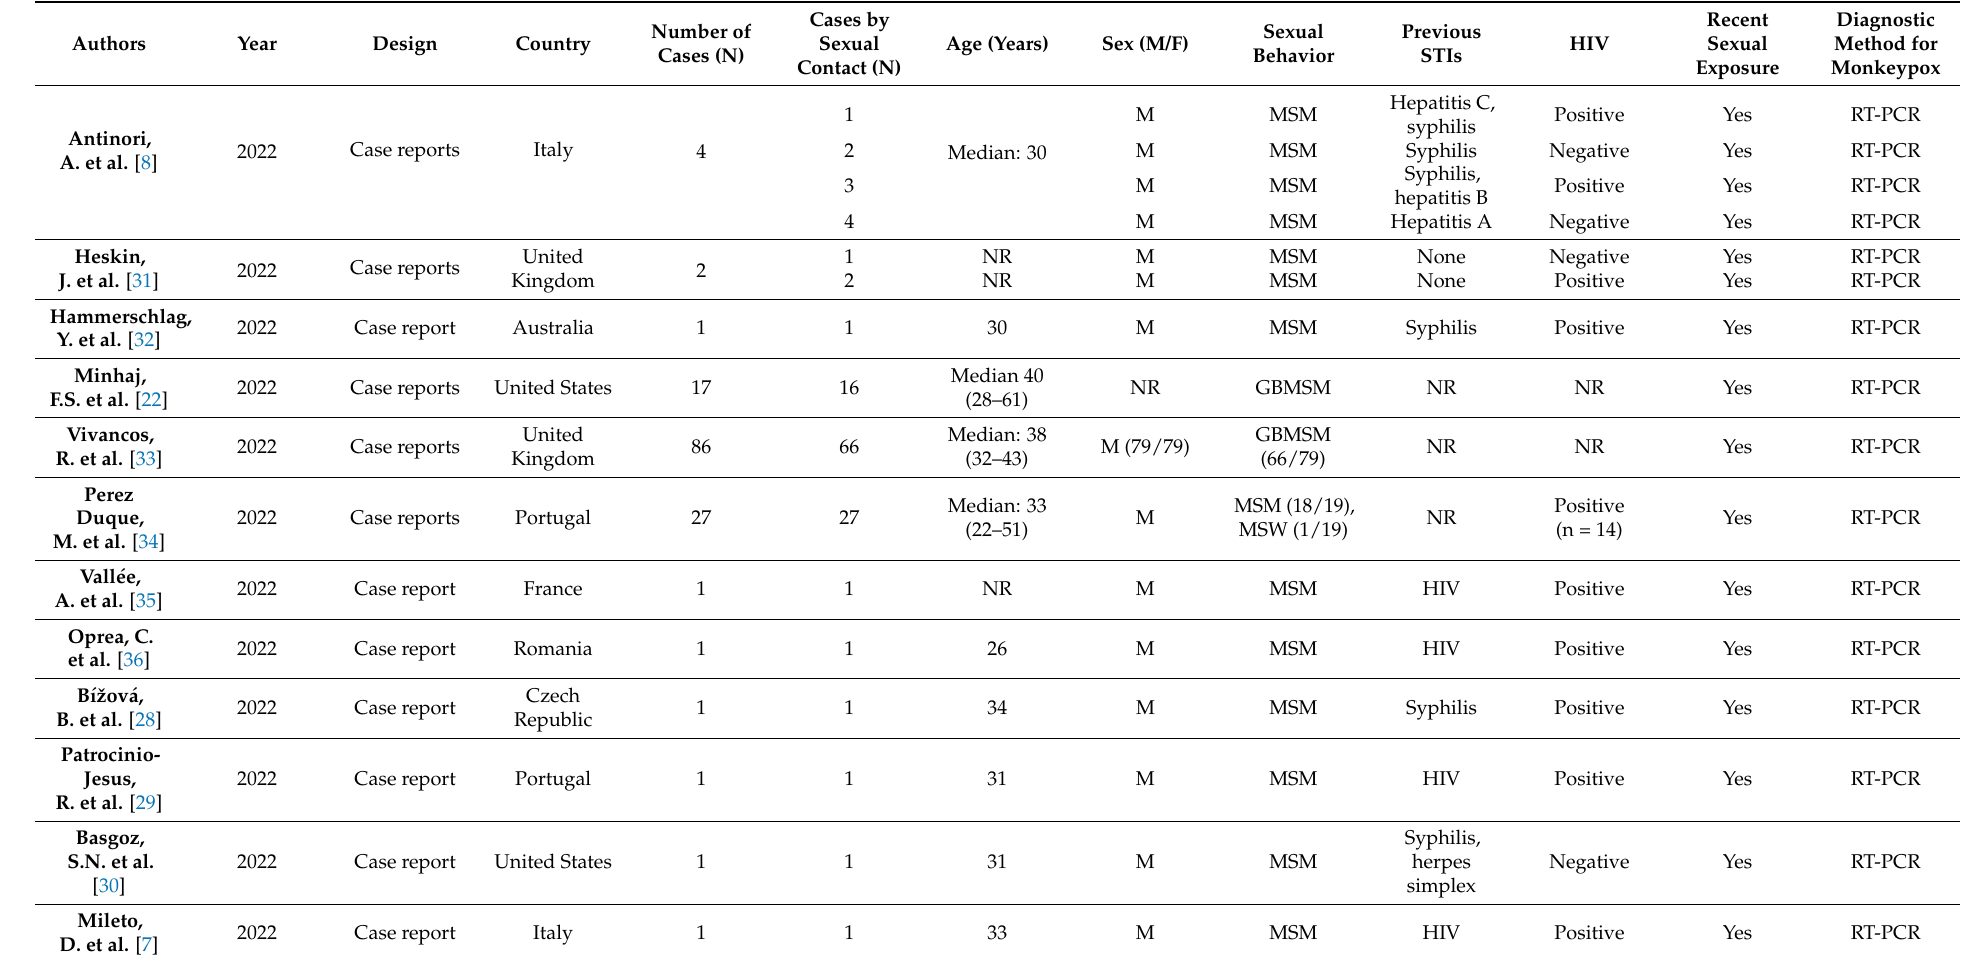
Table 2. Characteristics of included studies and description of case reports of